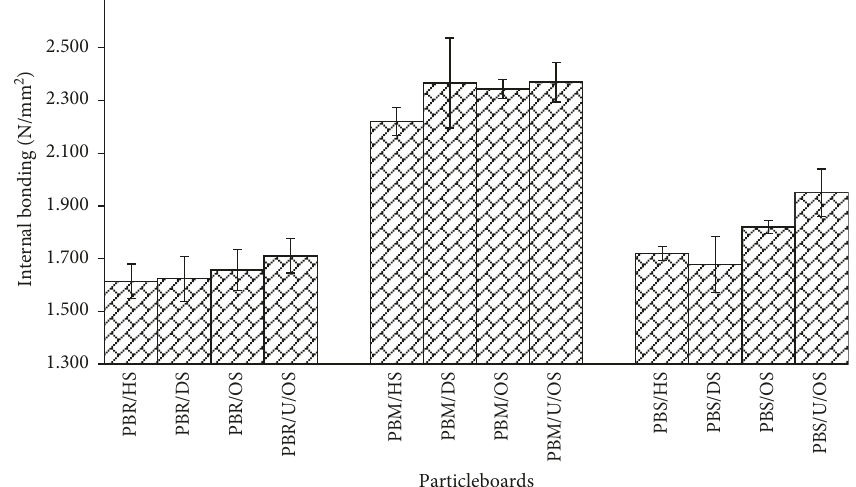
Figure 7: IB of the particleboards formulated using rice husks, maize stalk, and sugarcane